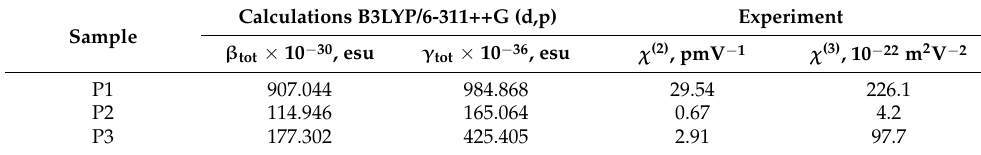
Table 4. Frequency-dependent β tot ( − 2 ω ; ω , ω ) and γ tot ( − 3 ω ; ω , ω , ω ) values at ω =